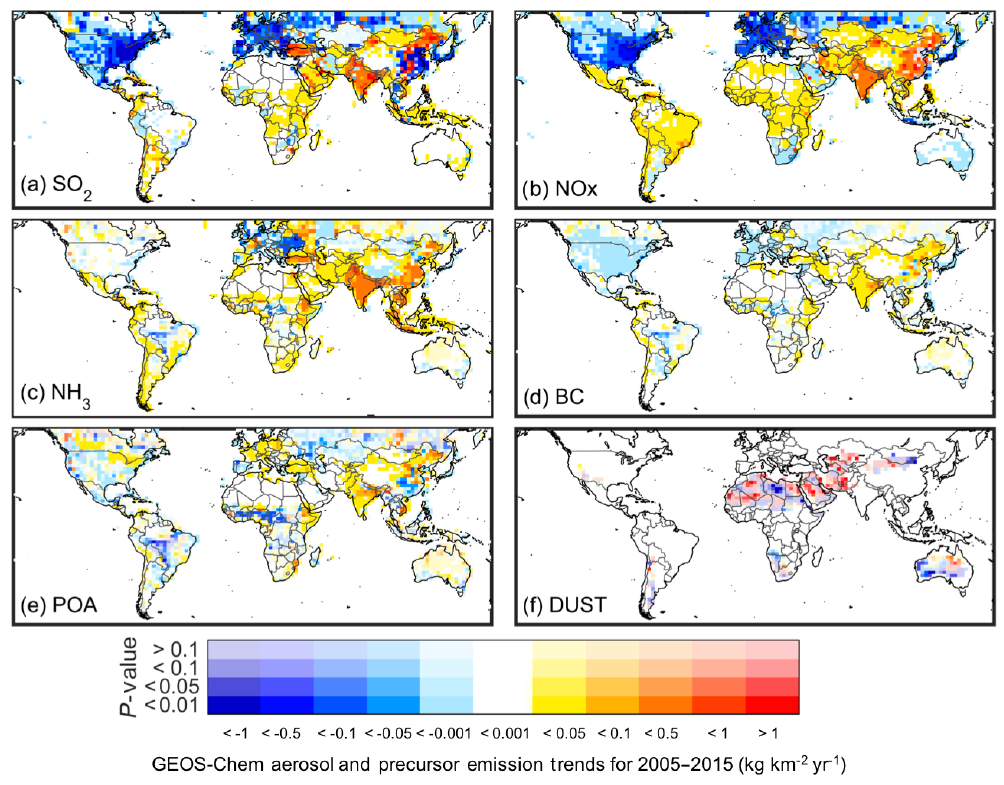
Figure 1. Trend in emissions of (a) sulfur dioxide (SO 2 ) (kgSO 2 km − 2 yr − 1 ), (b) nitrogen oxides (NO x ) (kgNOkm − 2 yr − 1 ), am- monia (NH 3 ) (kgNH 3 km − 2 yr − 1 ), black carbon (BC) (kgCkm − 2 yr − 1 ), primary organic carbon (POA) (kgCkm − 2 yr − 1 ), and dust (kgkm − 2 yr − 1 ) used in our GEOS-Chem simulation. The trends are calculated from the generalized least squares regression of monthly time series values during